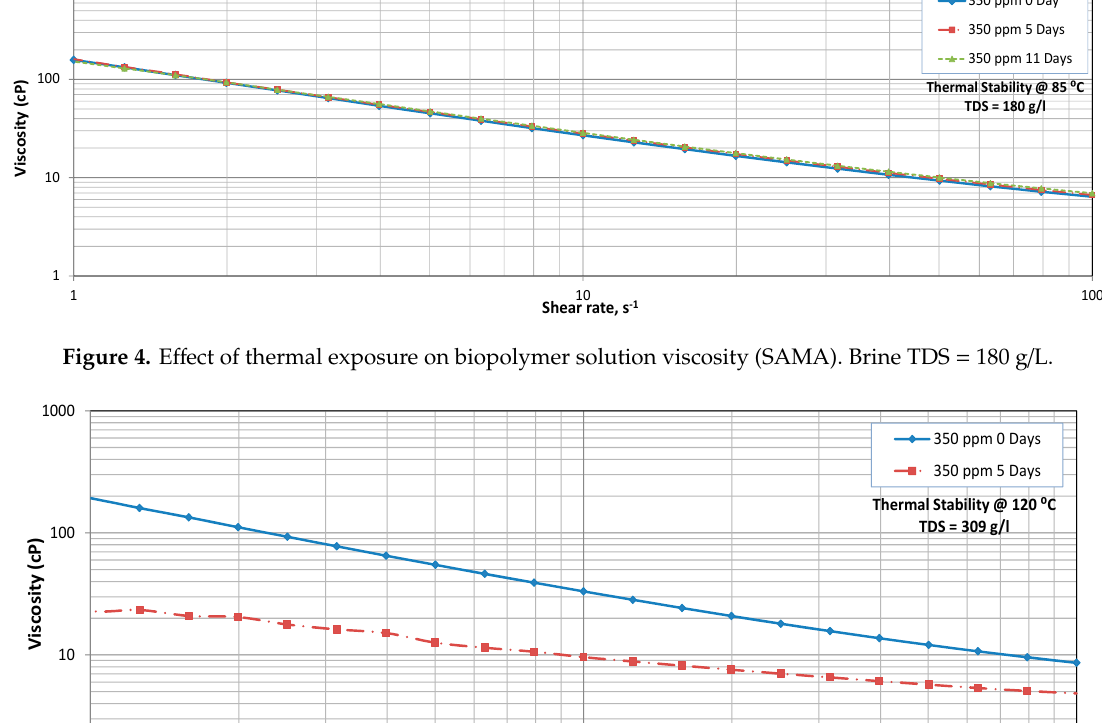
Figure 5. Effect of thermal exposure on biopolymer solution viscosity (extreme conditions). Brine TDS = 309 g/L